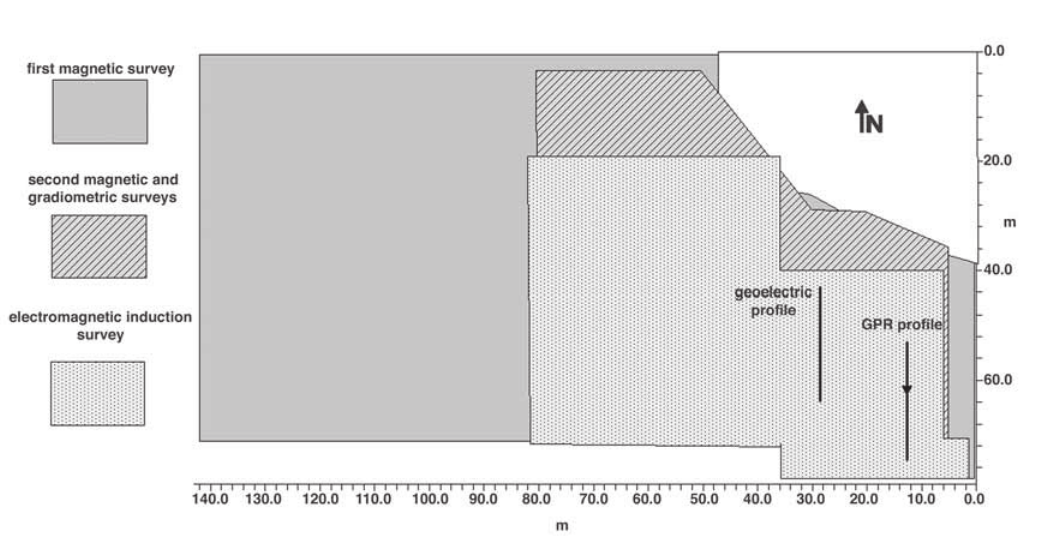
Fig. 2. General scheme of the different geophysical surveys carried out on the whole analysed